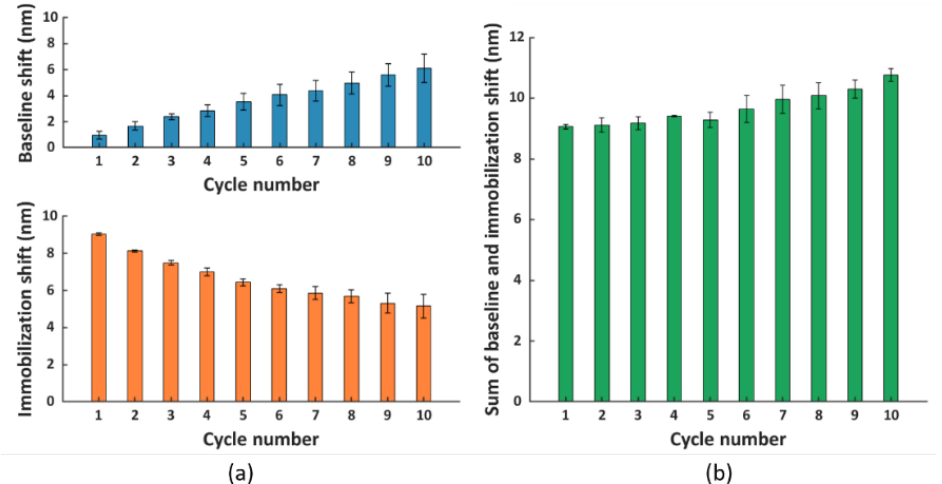
Figure 4. ( a ) The baseline (blue) and immobilization (orange) shift obtained in different cycles. ( b ) The sum of the immobilization shift per cycle and the baseline shift from the preceding cycle (except for cycle 1, where only immobilization shift is depicted as there is no baseline shift prior to this cycle). Each bar represents the average value of two parallel measurements performed on two different FO sensor probes, with error bars being standard deviations of the overall shift (n s =